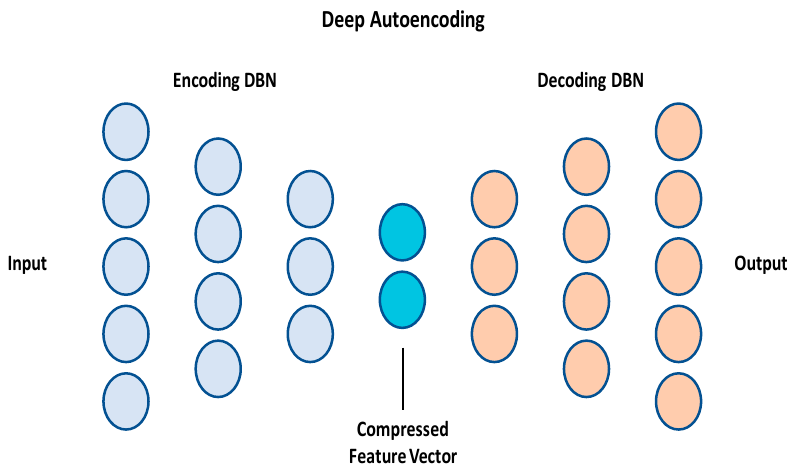
Figure 6. A representation of deep autoencoder